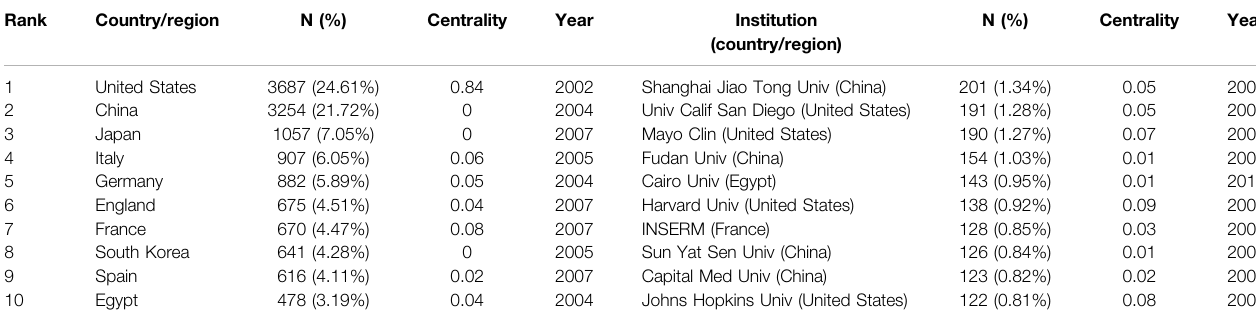
TABLE 1 | The top 10 countries/regions and institutions involved in the treatment of liver fi brosis.